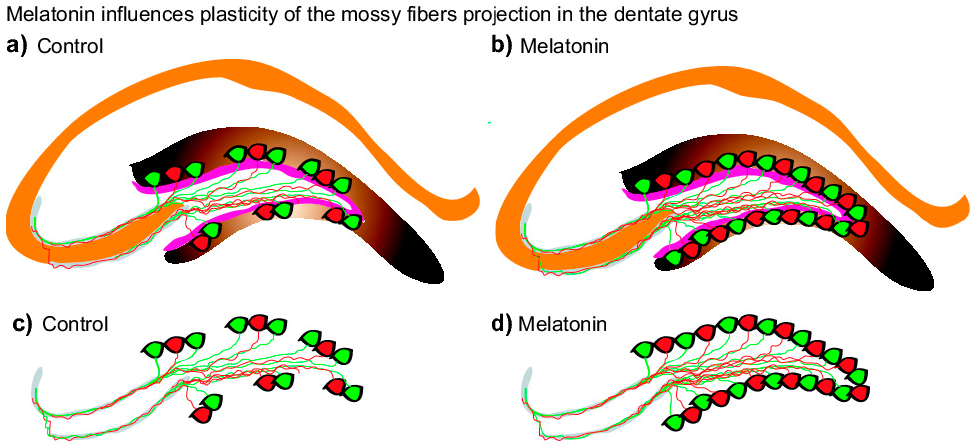
Figure 6. Schematic representation of the effects caused by melatonin on the volumes of mossy fiber projection. ( a – d ) After chronic administration of melatonin (8 mg/kg) for one- or six-months an increase in the mossy fiber projection was found in male Balb/C mice ( b , d ) compared to the vehicle treated group ( a , c ). Thus, the results suggest that melatonin plays a significant role in the plasticity of the mossy fibers projections that are also formed by axons of newborn- and mature-neurons in the dentate gyrus of the hippocampus.